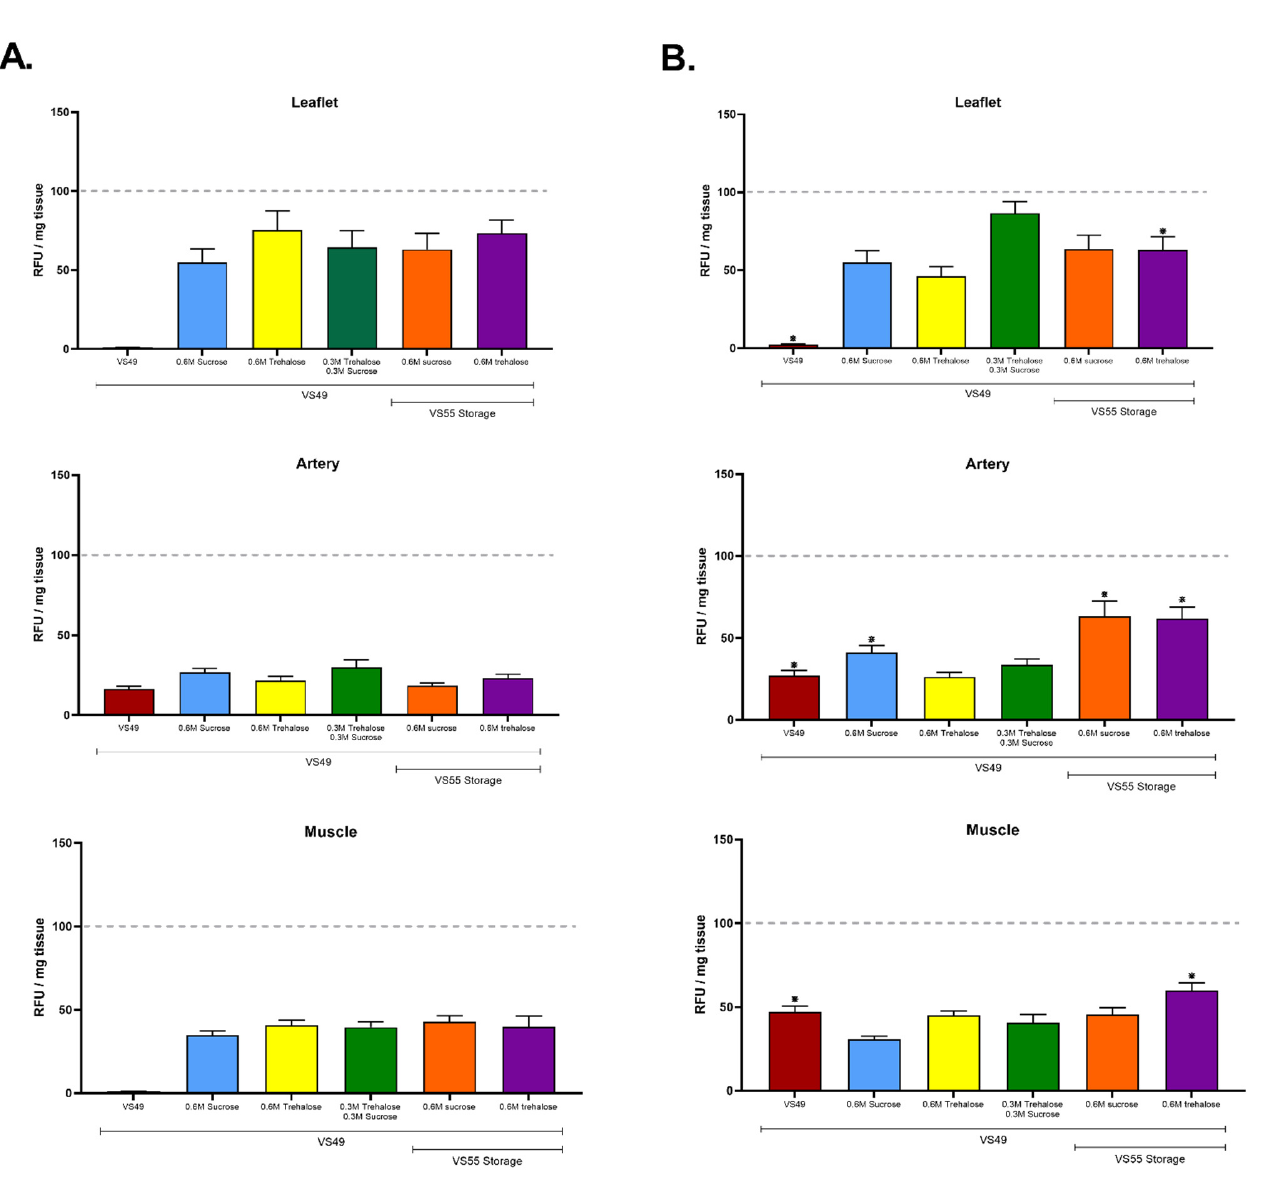
Figure 3. Ice-free vitrification of pulmonary heart valves comparing the impact of loading with VS49 on viability after vitrification in VS49 + disaccharides or VS55 + disaccharides. ( A ) No Fe, with boundary warming. ( B ) Nanowarmed with Fe. The top graph in each case is the leaflet, the center is the pulmonary artery, and the bottom is the fibrous muscle band at the base of the heart valve. Viability was assessed using alamarBlue. The best viability outcomes were observed employing nanowarming for each tissue type. The results are shown as the mean ± 1 standard error, p < 0.05. * comparison of ±